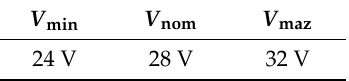
Table 2. DC bus voltage minimum, nominal and maximum level.